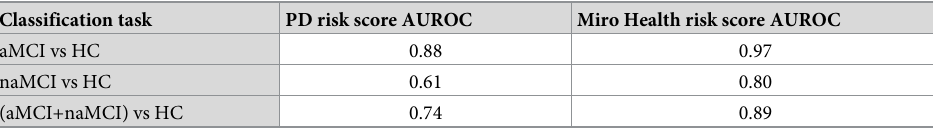
Table 4. Performance of MCI risk scores at separating cohorts of study